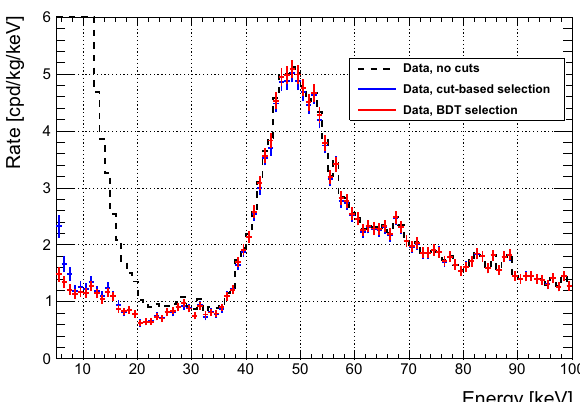
Fig. 11 NaI-33 low energy spectrum before (black dashed line) and after noise rejection. We show the result of the cut-based (blue points) andmultivariateBDT(redpoints)analyses.Theblueandredhistograms are corrected by the respective cut